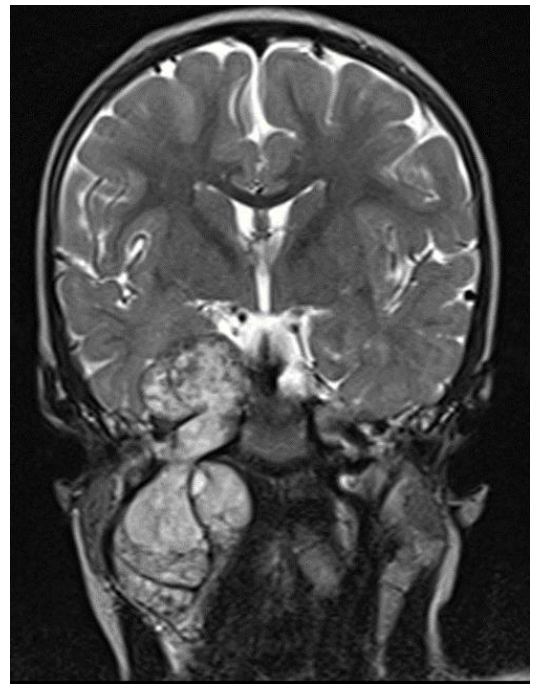
Figure 1. MRI T2 images, intratumor heterogeneity.